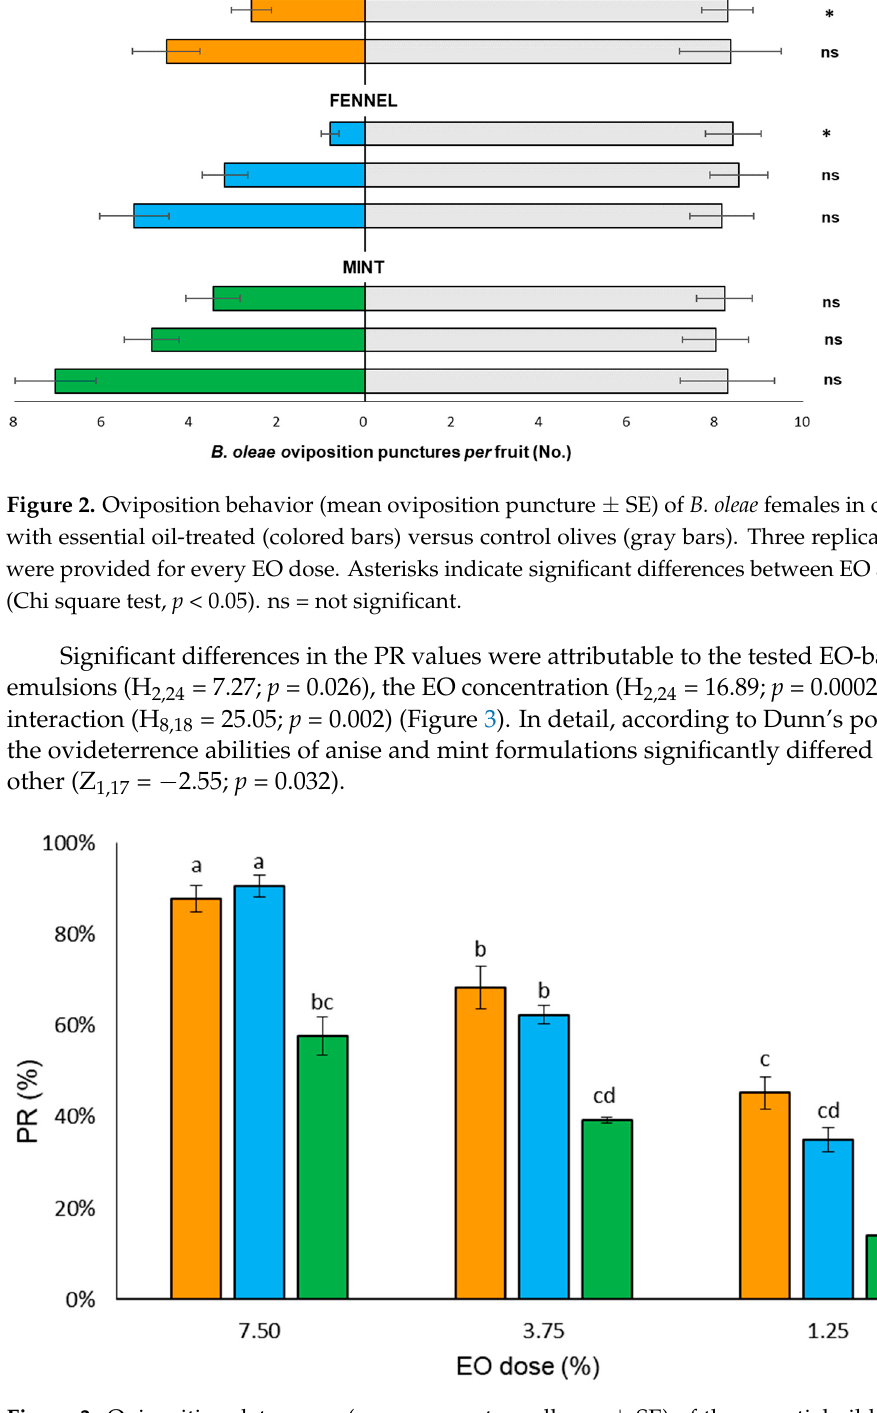
Figure 3. Oviposition deterrence (mean percent repellency ± SE) of the essential oil-based nano- emulsions toward B. oleae females in choice trials. Three replicates (n = 10) were provided for every EO dose. Orange bars = anise EO; blue bars = fennels EO; green bars = mint EO. Different letters indicate significant differences among the PR values (Dunn’s test, p < 0.05).